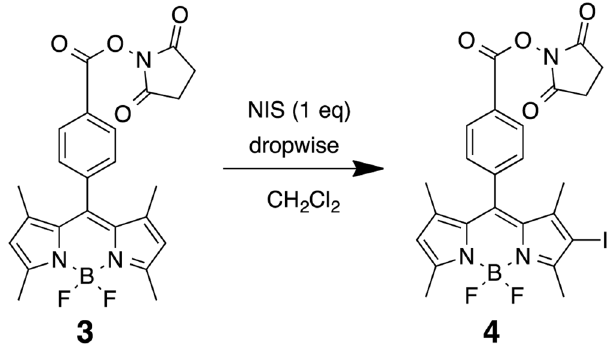
Figure 6. Iodination reaction of 3 (BODIPY-NHS).